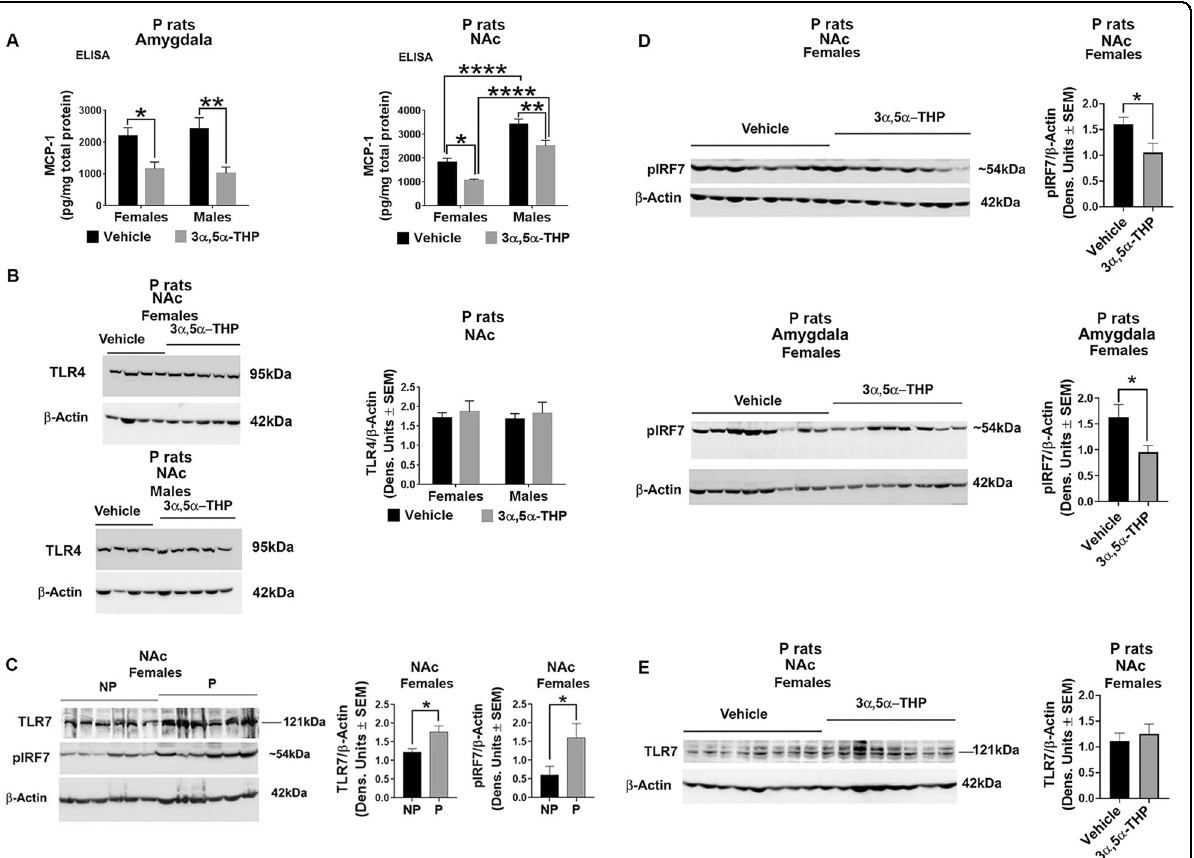
Fig. 2 3 α ,5 α -THP inhibits the innately activated MyD88-dependent TLR4 and TLR7 signals in the nucleus accumbens (NAc) and amygdala of P rats. A , B Male and female alcohol-preferring (P) rats ( n = 8/grp) were treated (IP; 30 min) with 3 α ,5 α -THP (15 mg/kg) or vehicle (45% w/v 2-hydroxypropyl- β -cyclodextrin) control and the amygdala and NAc were examined for MCP-1 and TLR4 expression. A There is no a signi fi cant sex difference for MCP-1 expression in the amygdala (Two-way ANOVA: F (1,28) = 0.02030, p = 0.8877, n = 8/grp). However, in the NAc there is a signi fi cant sex difference in the MCP-1 level (Two-way ANOVA: F (1,28) = 72.27, p < 0.0001, n = 8/grp). Speci fi cally, baseline MCP-1 levels are signi fi cantly higher in the NAc from males than females (Two-way ANOVA, Tukey ’ s post hoc test: **** p < 0.0001, n = 8/grp). 3 α ,5 α -THP administration signi fi cantly reduces MCP-1 expression in the male and female amygdala ( n = 8/grp) and NAc ( n = 8/grp) (Two-way ANOVA, Tukey ’ s post hoc test: * p < 0.05, ** p < 0.01). However, the total values of MCP-1 in the presence of 3 α ,5 α -THP are also higher in males than females (Two-way ANOVA, Tukey ’ s post hoc test: **** p < 0.0001, n = 8/grp) in P rat NAc. B The levels of TLR4 are similar in the males and females NAc tissues (Two-way ANOVA: F (1,28) = 0.06052, p = 0.8075, n = 8/grp) and they are not altered by 3 α ,5 α -THP treatment (Two-way ANOVA: F (1,28) = 0.4218, p = 0.5213, n = 8/grp). C The TLR7 signal is innately activated in female P rats. NAc tissues from male and female alcohol-preferring (P) ( n = 6/grp) and non-preferring (NP) control ( n = 6/grp) rats were assayed for the expression of TLR7 and pIRF7, which is indicative of TLR7 signal activation. The levels of TLR7 and pIRF7 are signi fi cantly higher in female P than NP rats ( t -test: * p < 0.05, n = 8/grp) consistent with innate TLR7 activation in female P rats. The levels of TLR7 and pIRF7 are similar in male P and NP rats (SI, Fig. S1). D , E Female P rats ( n = 8/grp) were treated (IP; 30 min) with 3 α ,5 α -THP or vehicle control and the NAc and amygdala were examined for expression of TLR7 and pIRF7 (indicative of TLR7 activation). 3 α ,5 α -THP administration signi fi cantly reduced pIRF7 expression in the NAc and amygdala from female P rats ( t -test: * p < 0.05, n = 8/grp) ( D ), but it had no effect on TLR7 expression in female P rat NAc ( t -test, p > 0.05, n = 8/grp) ( E